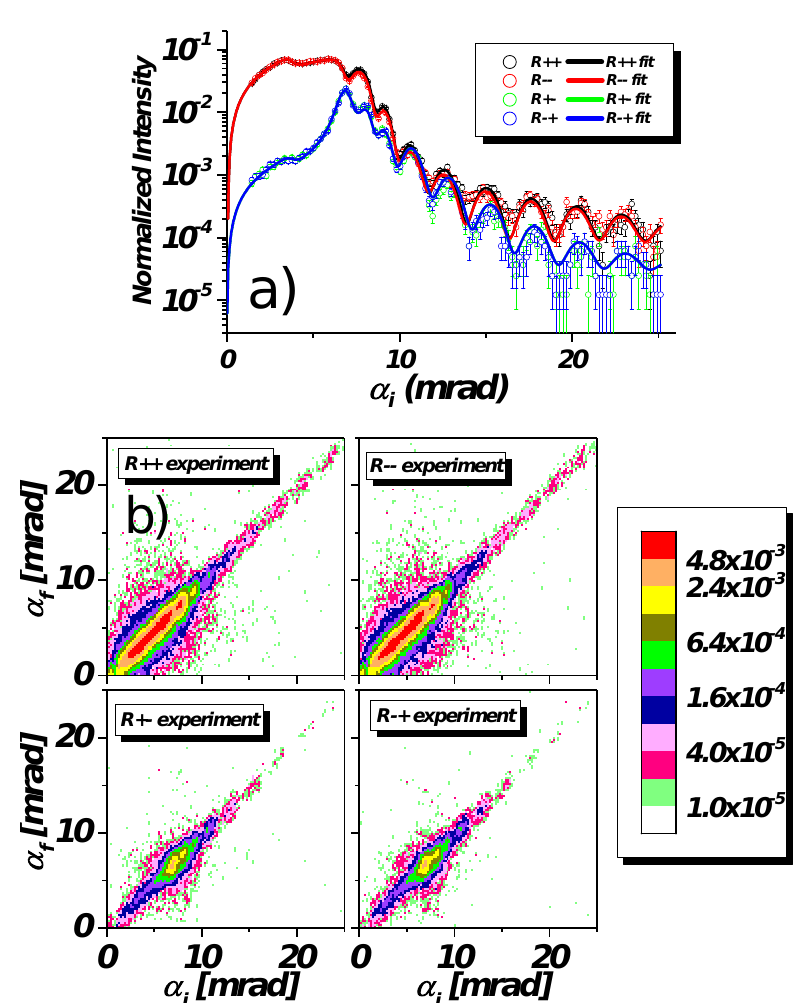
Figure 9. ( a ) NSF and SF reflectivities for the stripes oriented parallel to the scattering plane as in Figure 8 but in a guiding field of H ext = 5 Oe after the sample was saturated in 5 kOe applied parallel to the stripes. Solid lines are fits to the experimental data. ( b ) Off-specular scattering